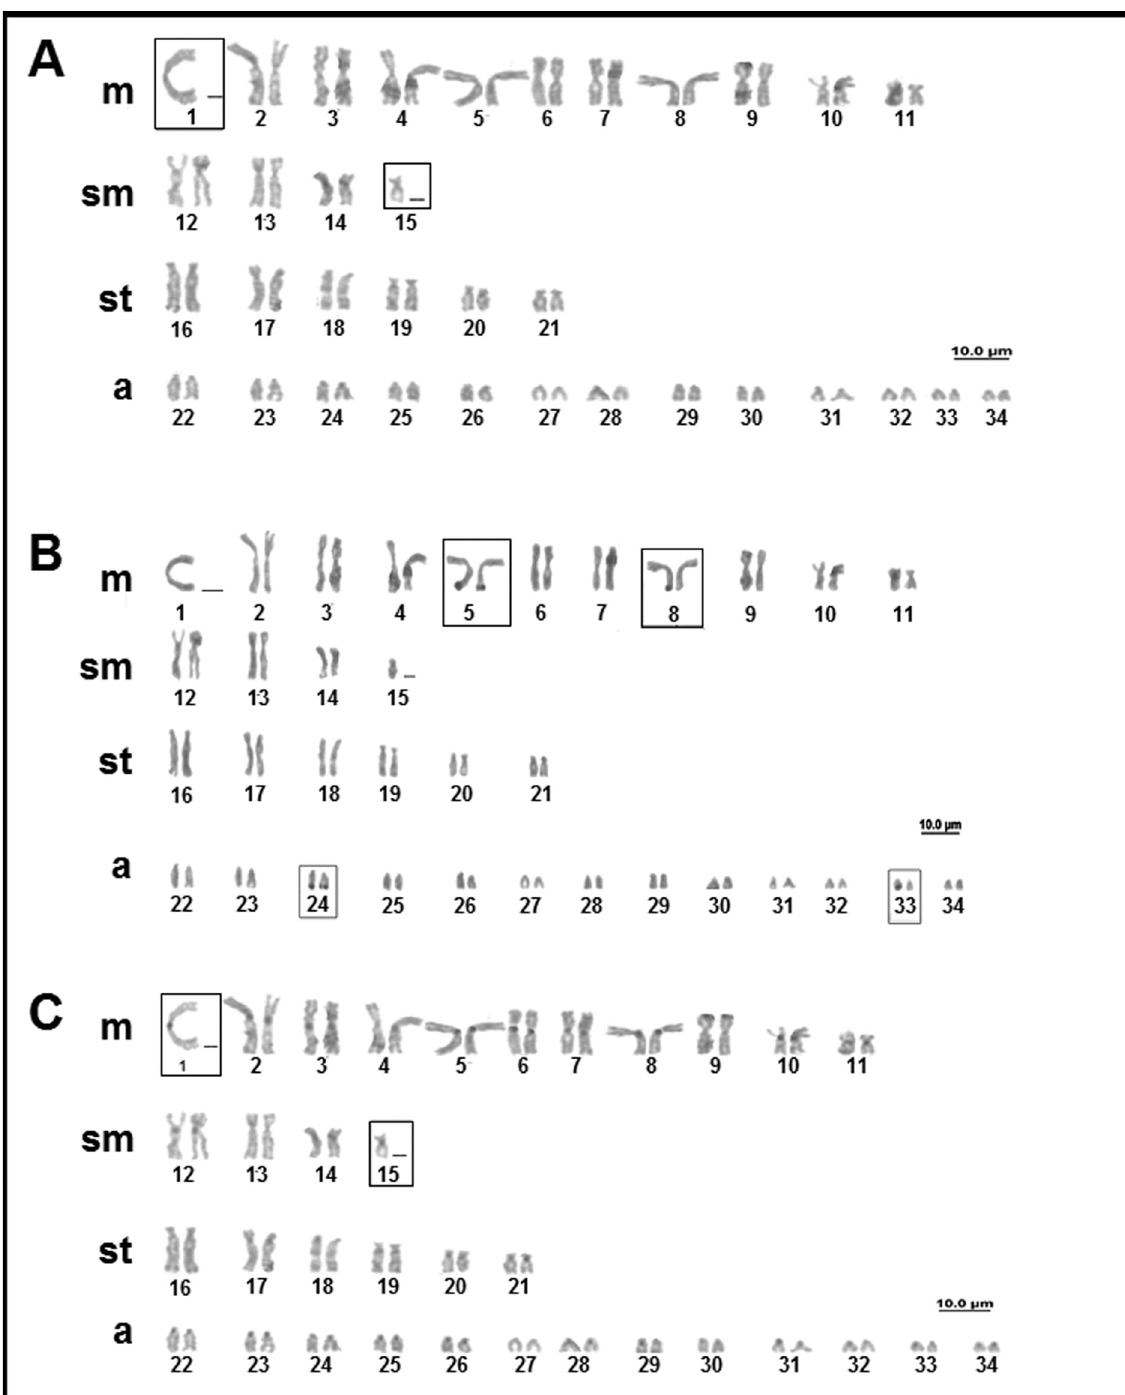
Figure 3 - Karyotype of Potamotrygon amazona (male): (A) conventional Giemsa staining; (B) sequential AgNO 3 ; (C) sequential